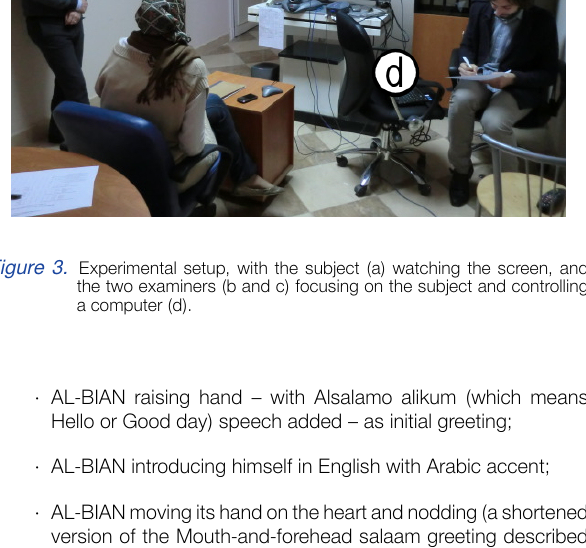
Figure 2. Twoscreenshotsof the videoshown to the participants. (a): the robot KOBIANperformingabow. (b): theficticialrobotAL-BIANperforming a salaam greeting. They are in fact the same robot.